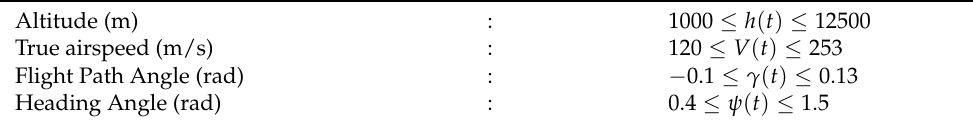
Table 1. Constrains of the flight of the case study.